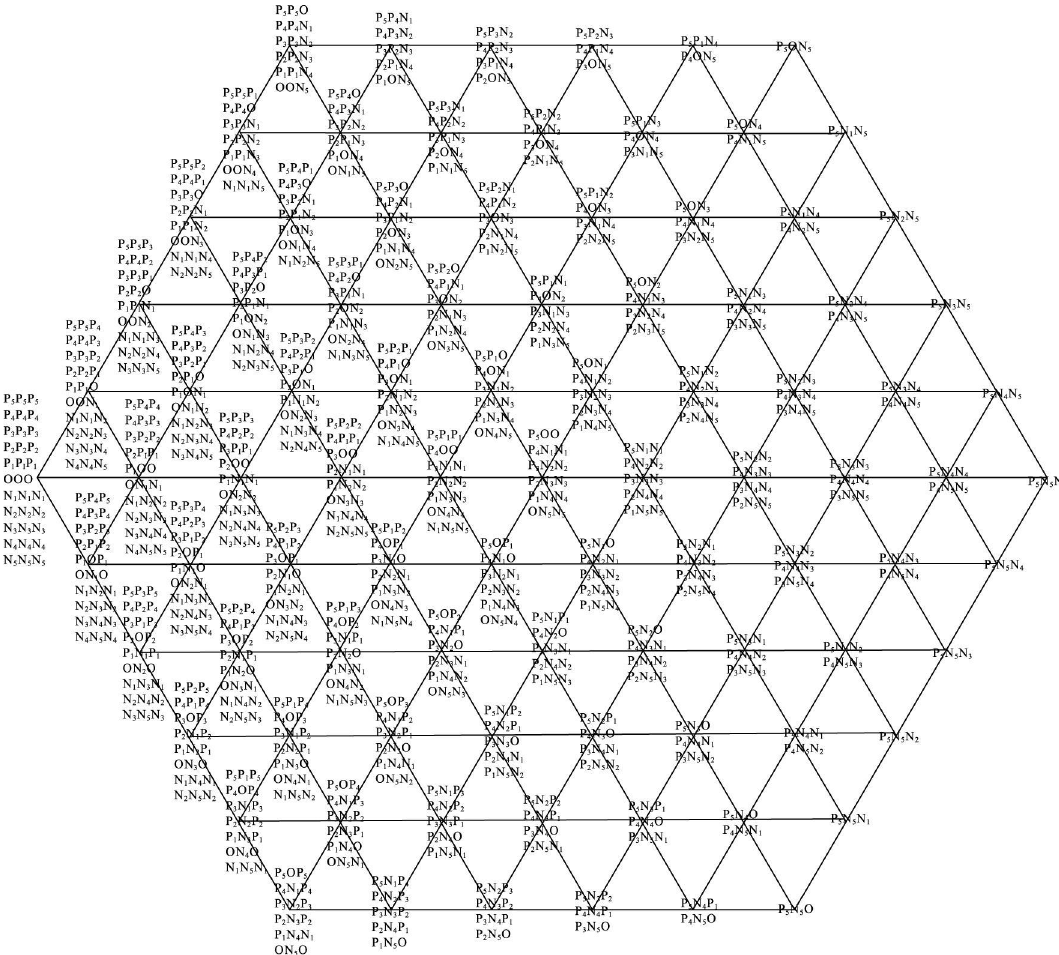
Figure 5: Switching states of 6L hexagon-I.